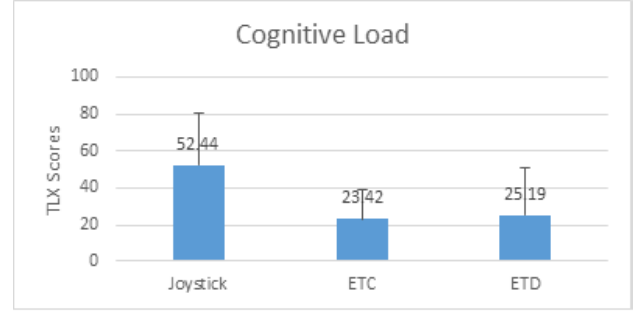
Figure 36. Analysing cognitive load in the flight simulator.